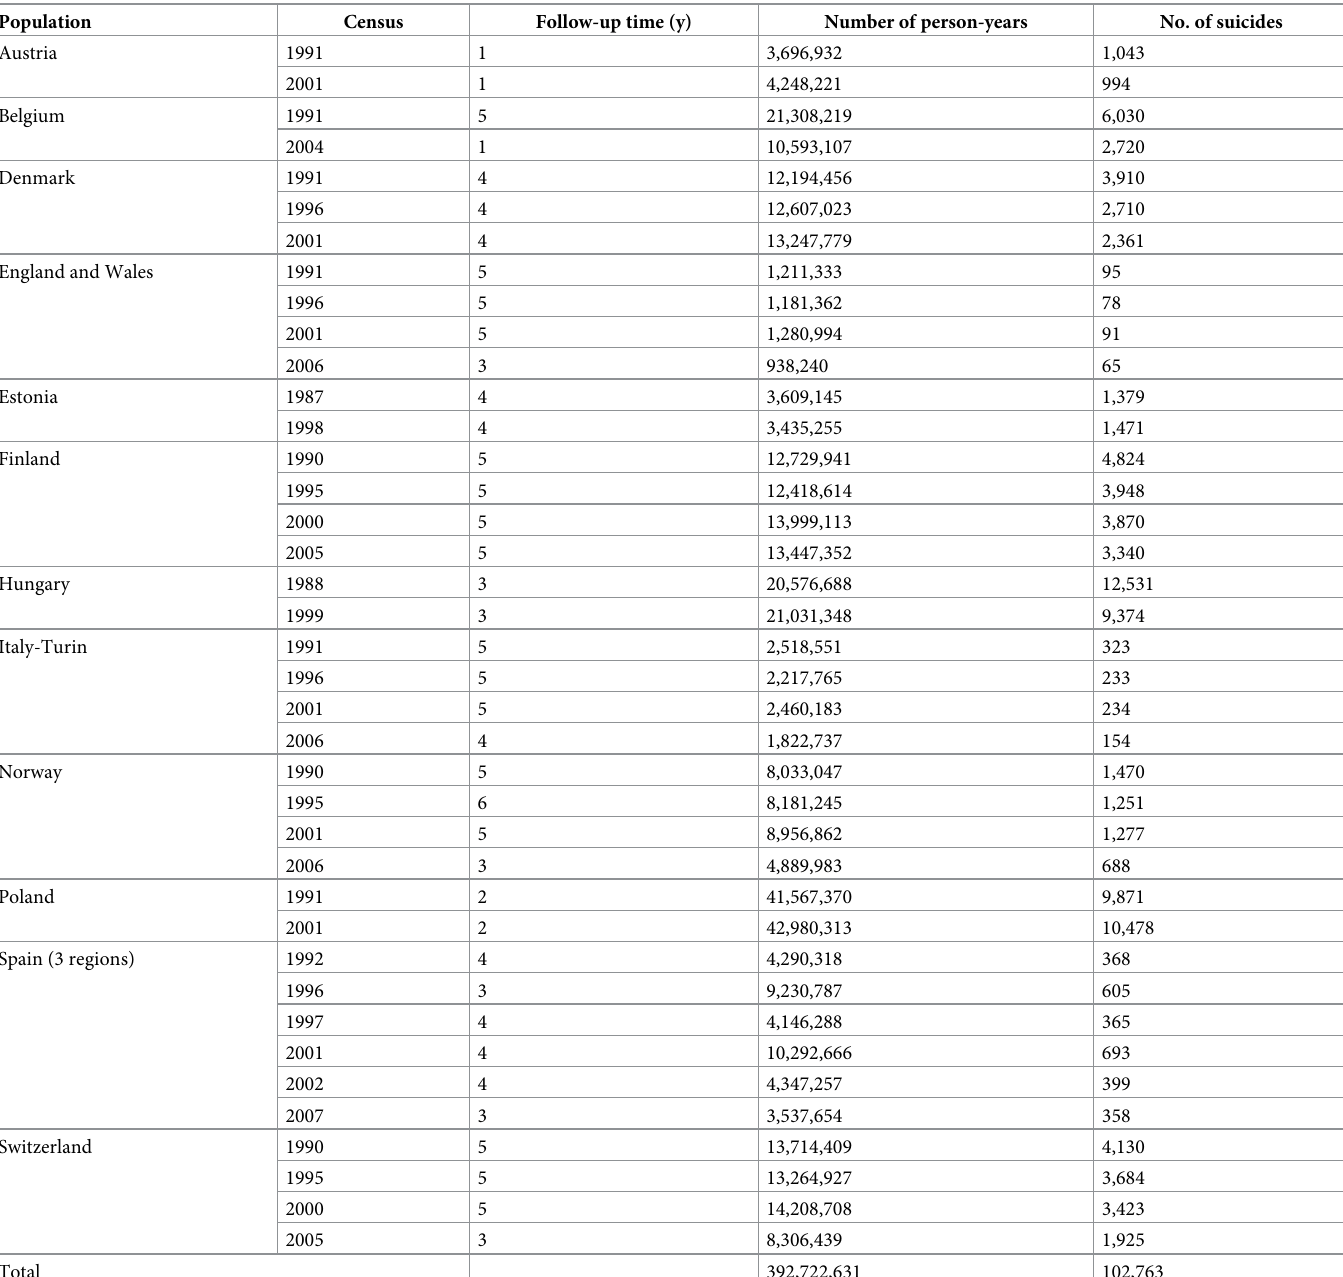
Table 1. Number of person-years and number of suicides per population and census, DEMETRIQ study from twelve European populations, 1991–2001.